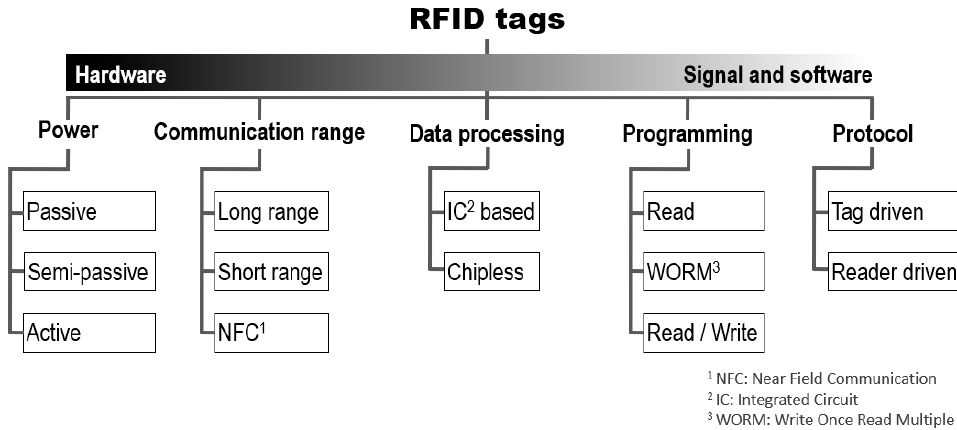
Figure 2. Classification according to several criteria of the different families of tags.